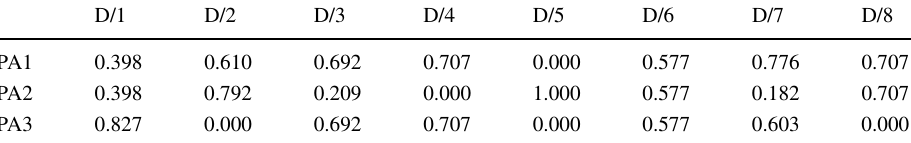
Table 14 Normalized DM